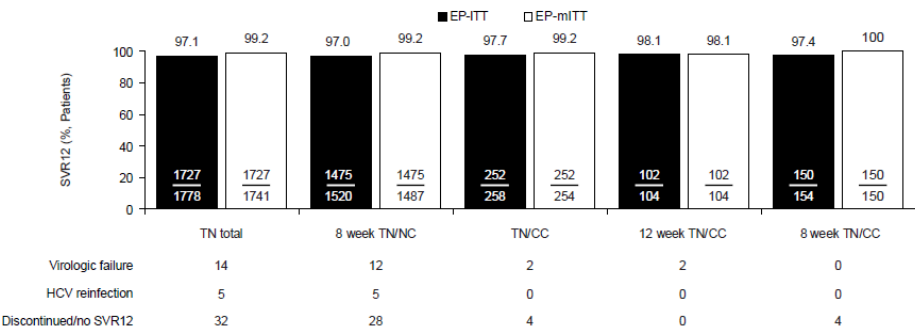
Figure 2. SVR12 rates among TN patients who received GLE/PIB according to cirrhosis status and treatment duration. CC, compensated cirrhosis; EP, effectiveness population; HCV, hepatitis C virus; ITT, intention to treat; mITT, modified intention to treat; TN, treatment-naïve; SVR12, sustained virologic response at PTW12.